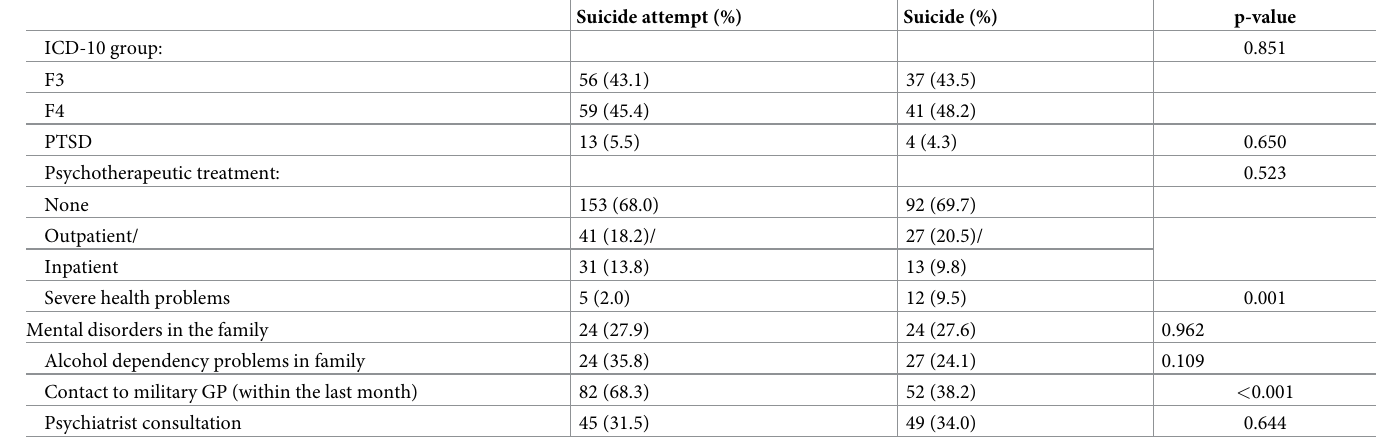
Table 2. Medical